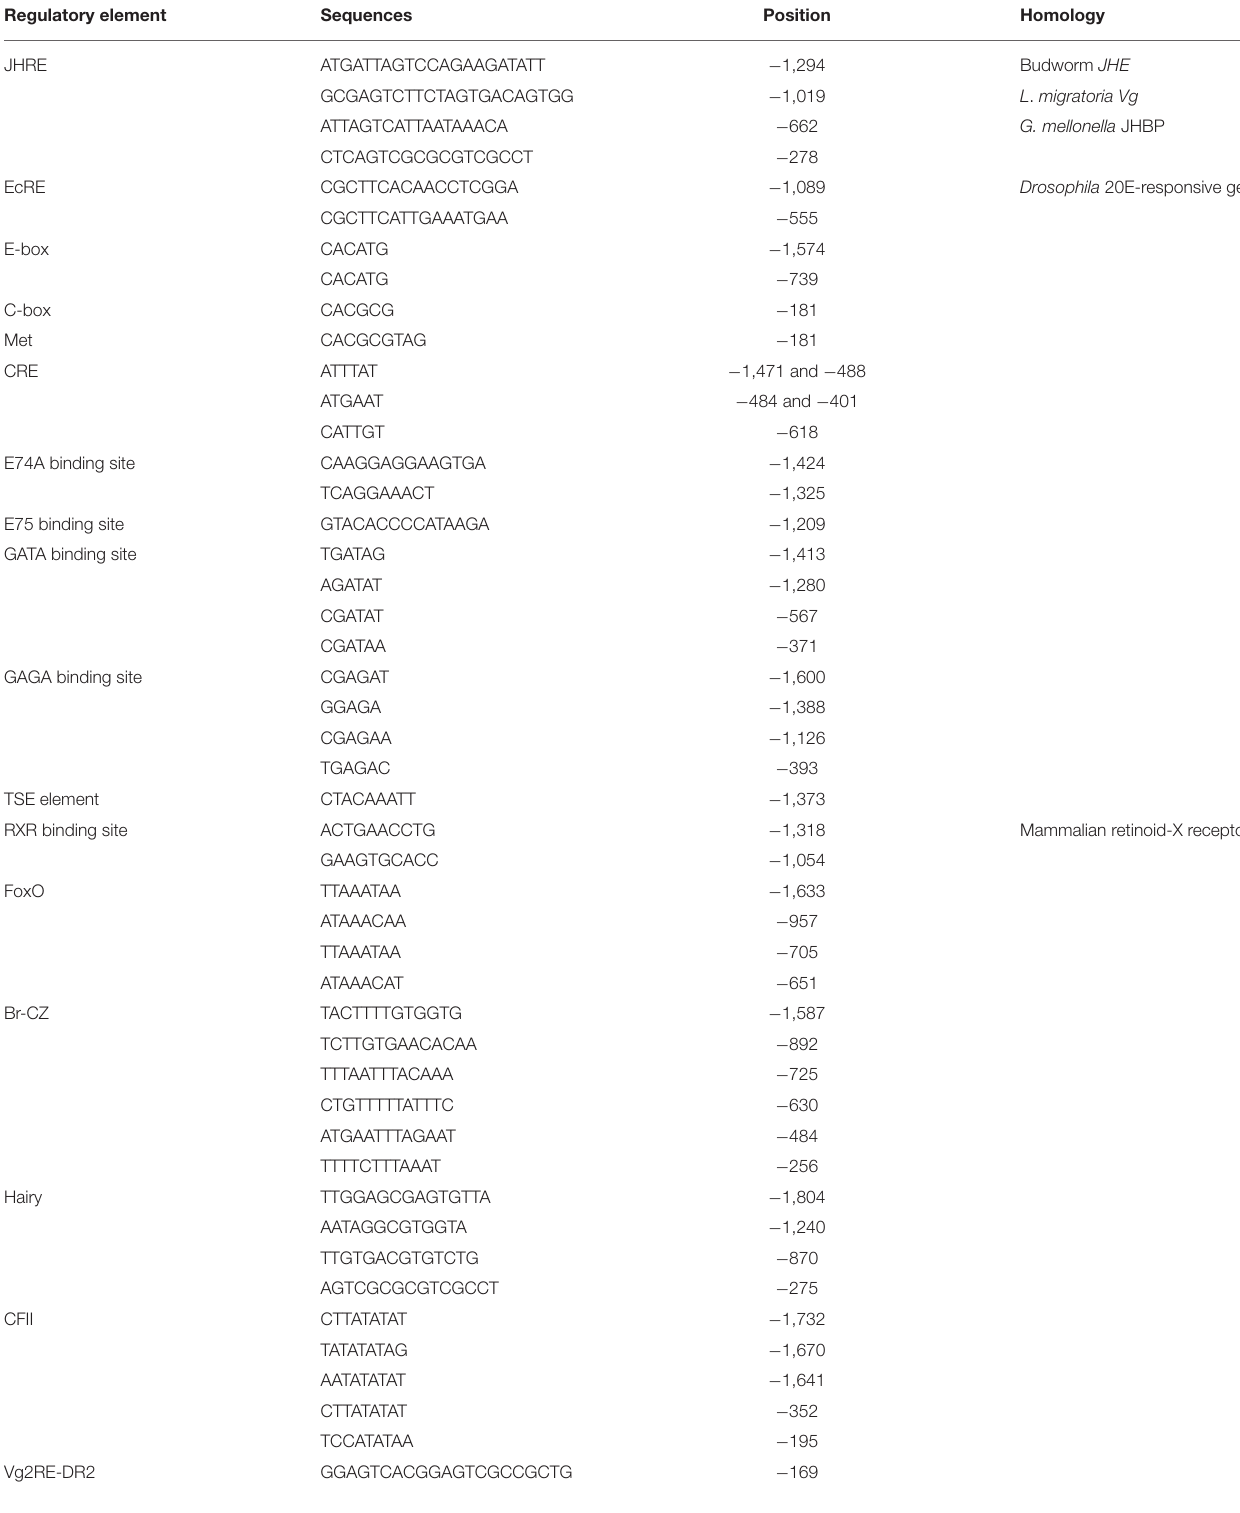
TABLE 1 | Possible regulatory elements located in the promoter region of the Vg2 gene. Regulatory